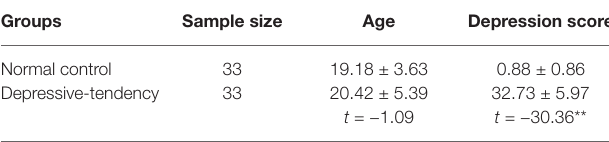
TABLE 1 | Basic information of participants (M ±